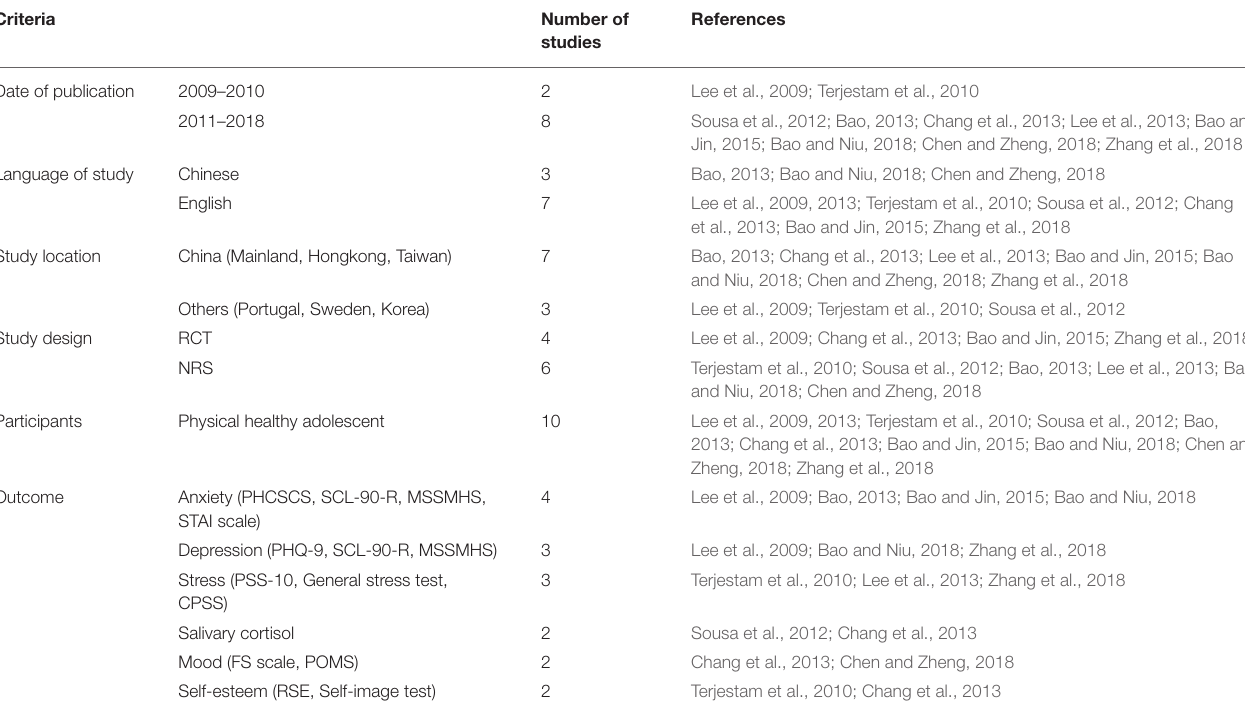
TABLE 1 | Summary of studies